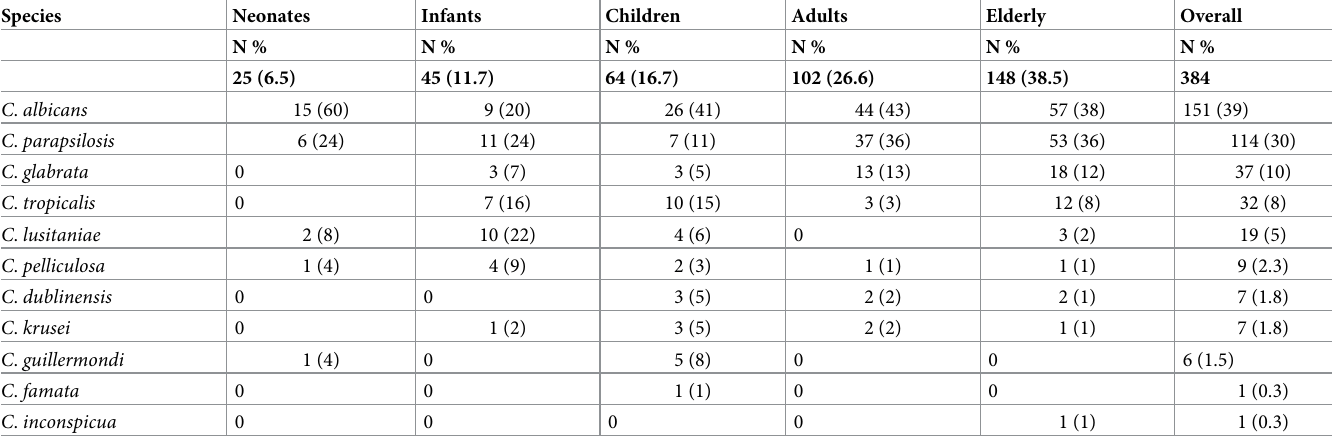
Table 1. Species distribution in 384 episodes of candidemia, by age group.